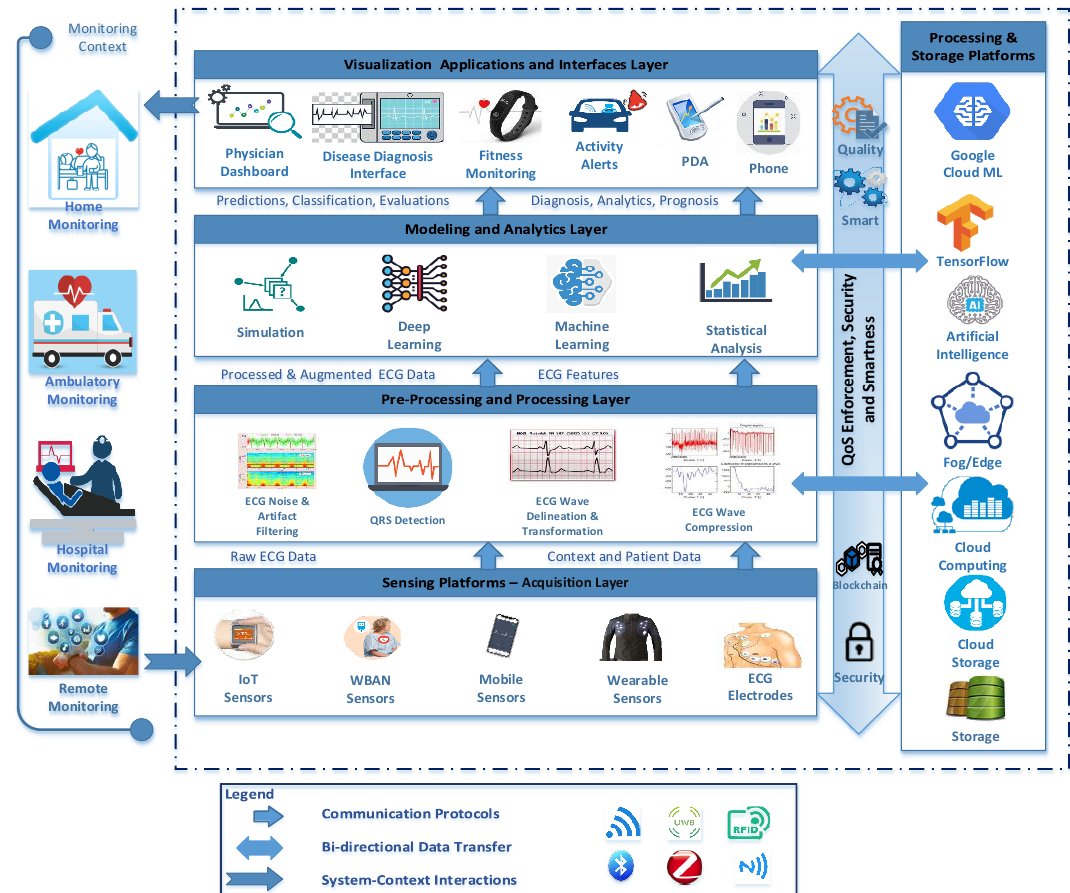
Figure 1. The overall architecture of electrocardiogram (ECG) monitoring systems.